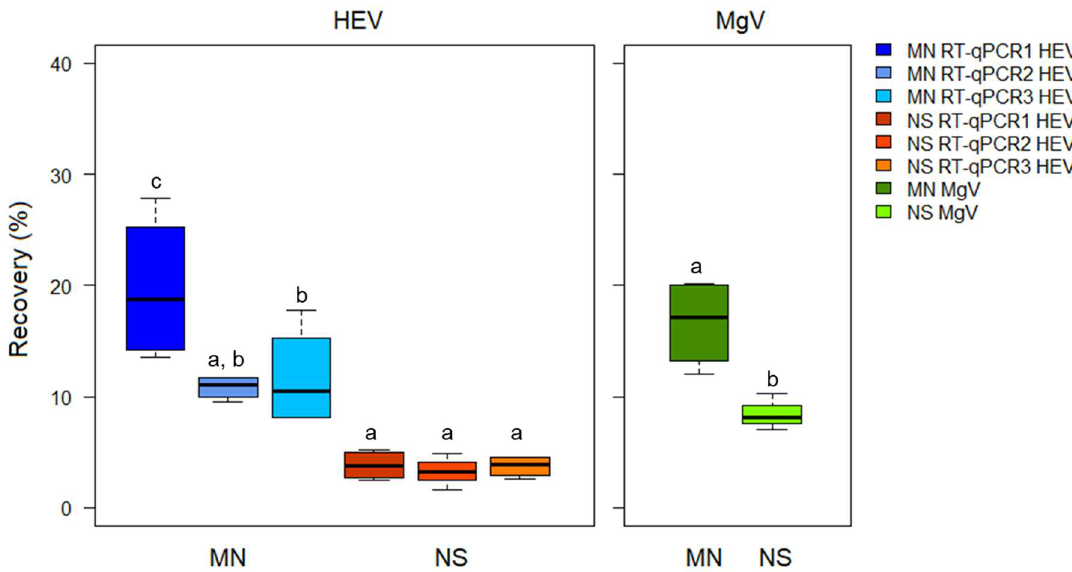
Figure 1. Hepatitis E virus (HEV) recovery in bottled water samples using the ISO 15216-1:2017 procedure and comparing two extraction kits and three RT-qPCRs assays. MN: NucleoSpin ® RNA virus kit (Macherey-Nagel GmbH & Co.); NS: NucliSens® MiniMag® system (BioMerieux SA); RT-qPCR1: modified from [20]; RT-qPCR2: CeeramTools® Hepatitis E Virus Detection KHEV kit (BioMérieux SA); and RT-qPCR3: Described in [21] and modified in [22]. Different letters denote significant differences among methods for each virus ( p < 0.05).